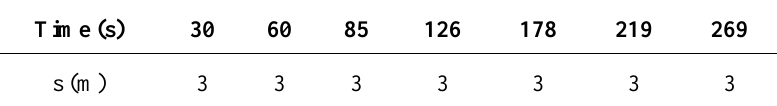
Table 5. Gross errors added to the step length measurements.